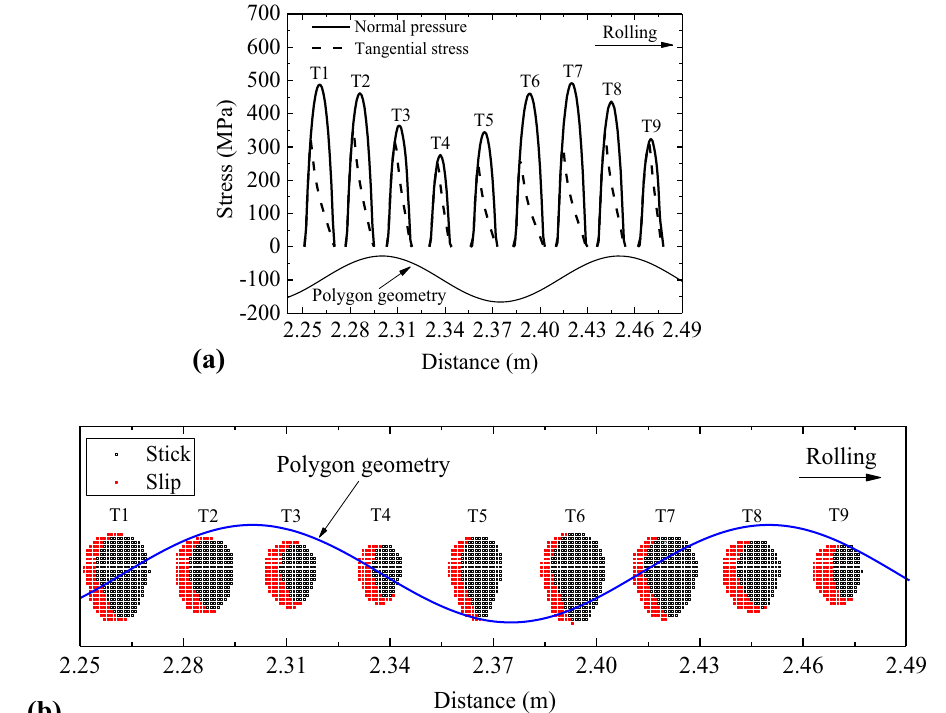
Fig. 7 a Dynamic response of contact stress distribution and b stick–slip distribution within contact patch [29]. The running speed is 300 km/h, and the wavelength of wheel polygonal wear is approximately 150